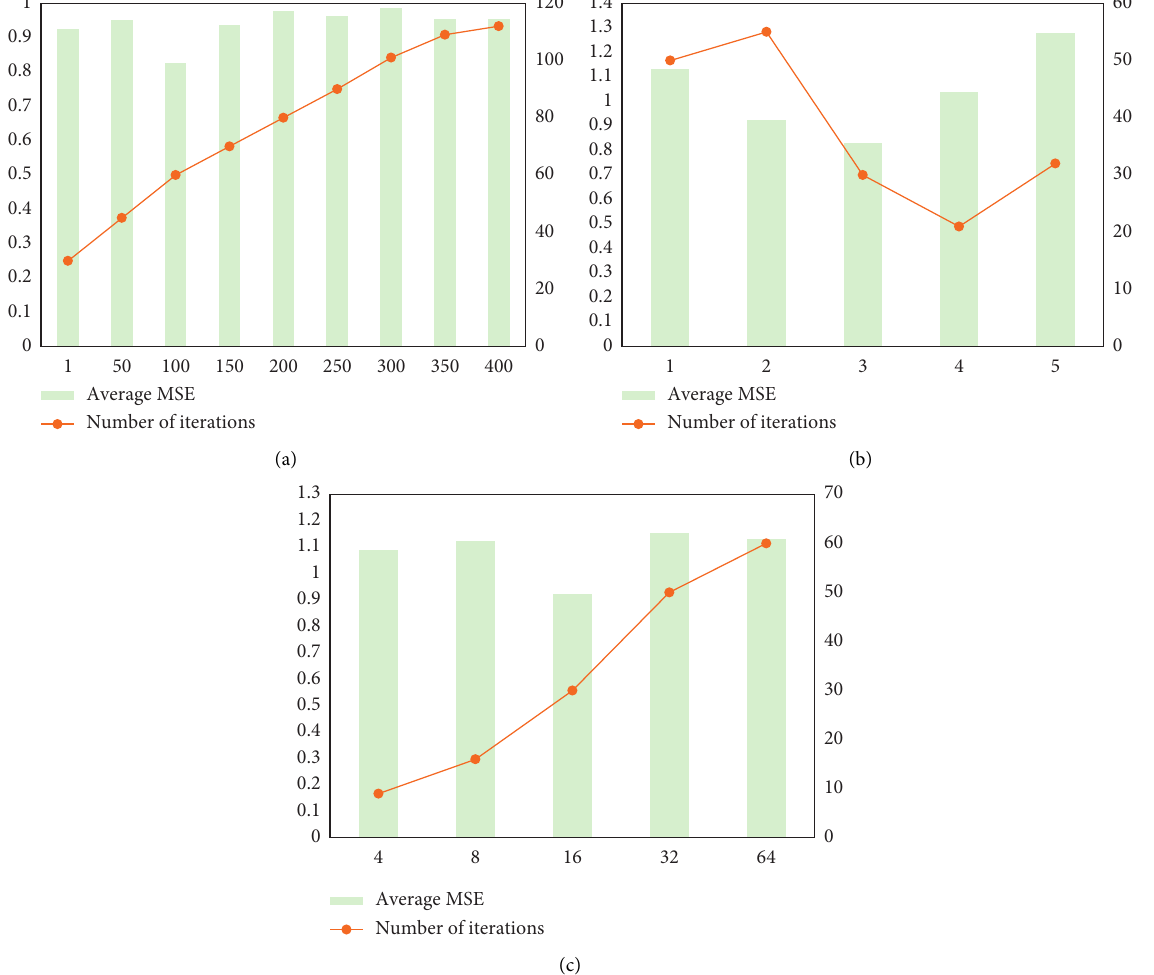
Figure 5: The influence of different numbers of parameters on the model in this article. (a) Comparison of related indicators under different word vector dimensions. (b) Comparison of related indicators under different convolutional layers. (c) Comparison of related indicators under different numbers of convolutional kernels.